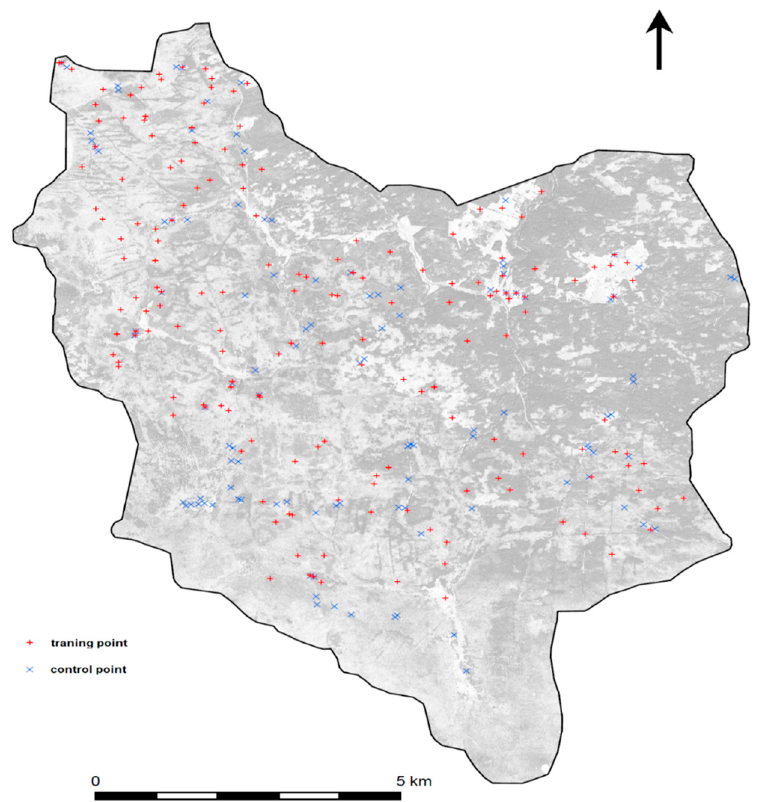
Figure A16. The location of the training and control points.